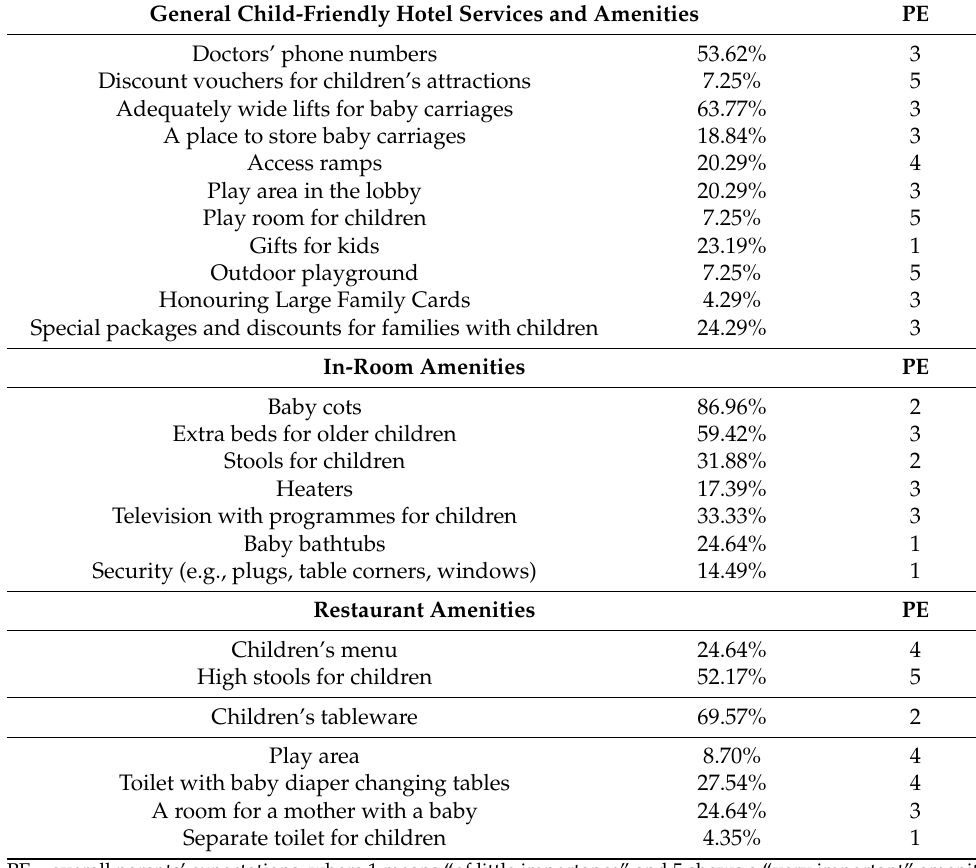
Table 1. The percentage of hotels with the amenities listed and a point value indicating parents’